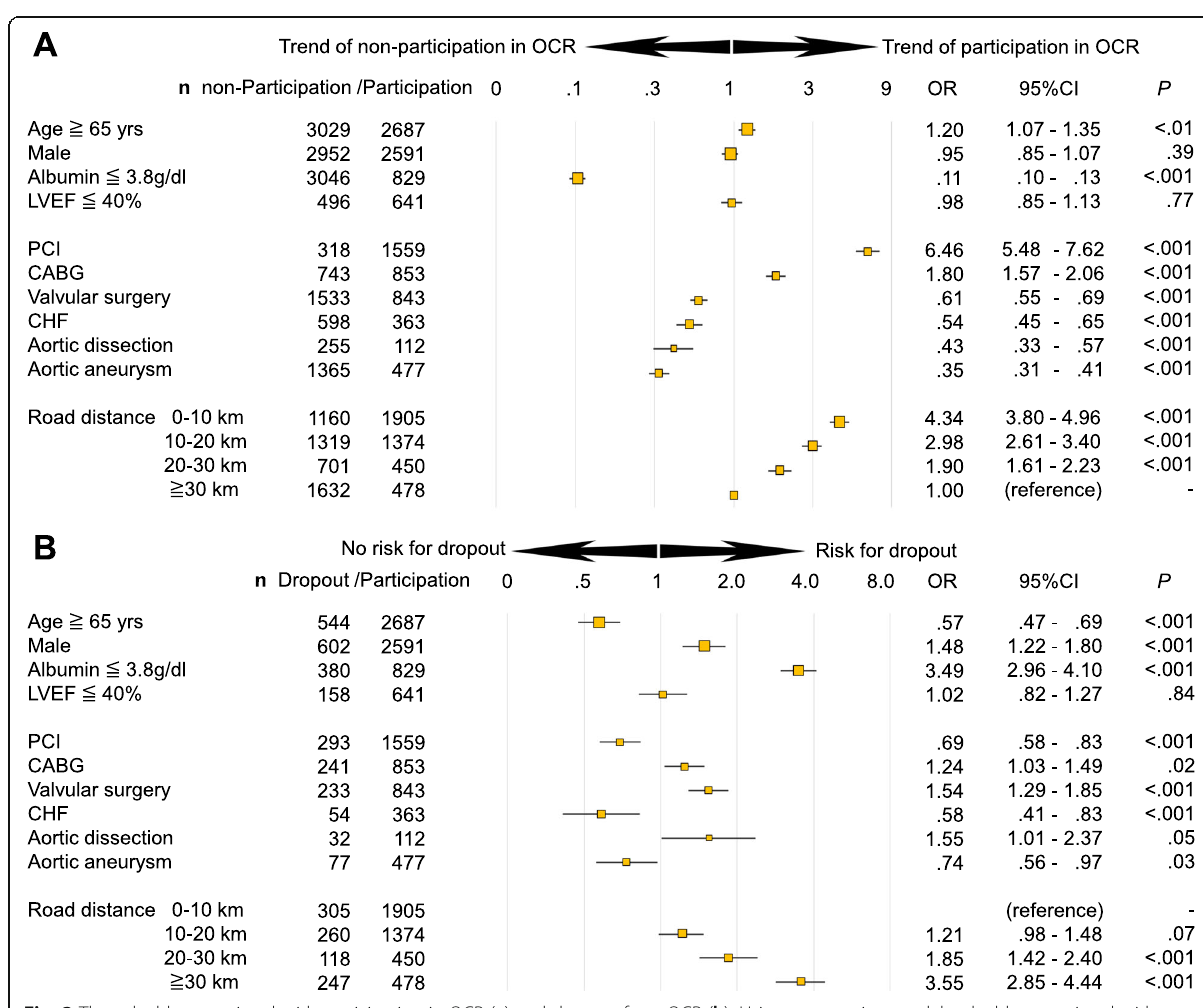
Fig. 3 The valuables associated with participation in OCR ( a ) and dropout from OCR ( b ). Using a regression model, valuables associated with participation in OCR in all study population ( n = 9019) (non-participation in OCR ( n = 4812) versus participation in OCR ( n = 4207)) ( a ) and dropout from OCR ( n = 930) versus participation in OCR ( n = 4207) ( b ) were analyzed. OCR, outpatient cardiac rehabilitation; LVEF, left ventricular ejection fraction; PCI, percutaneous coronary intervention; CABG, coronary artery bypass grafting; CHF, congestive heart